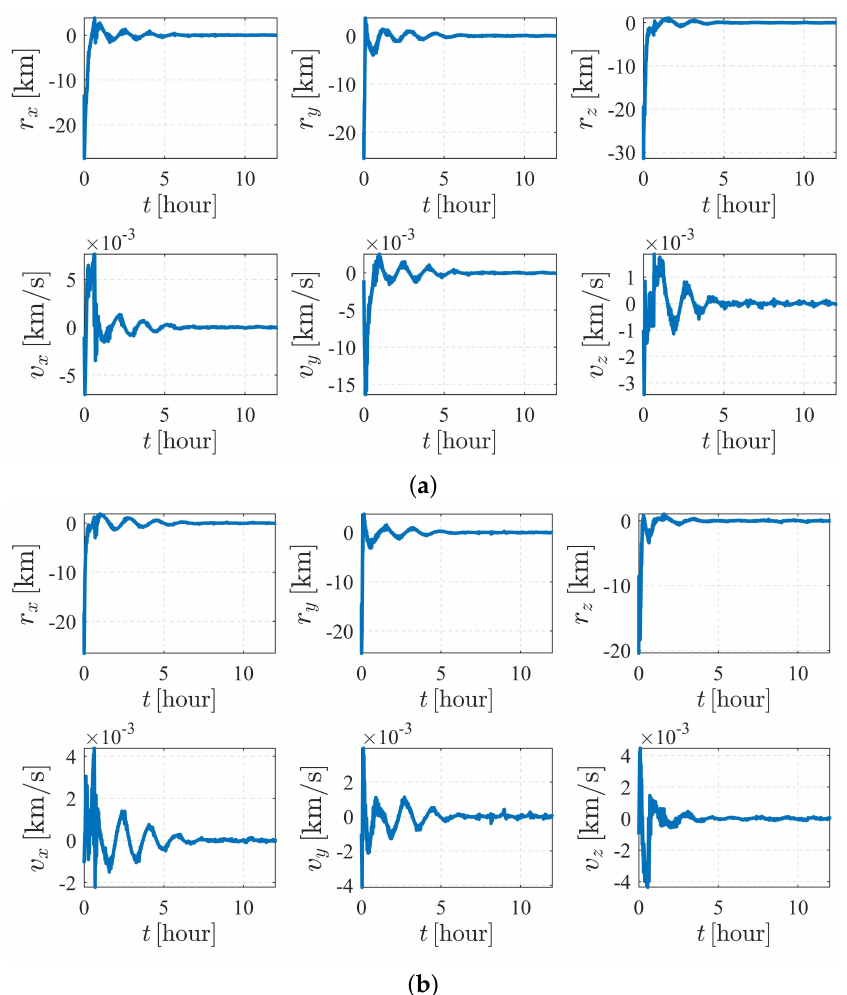
Figure 16. Orbit determination errors of case IV (nonperturbation). ( a ) Orbit estimation errors of spacecraft S 1 . ( b ) Orbit estimation errors of spacecraft S 2 .